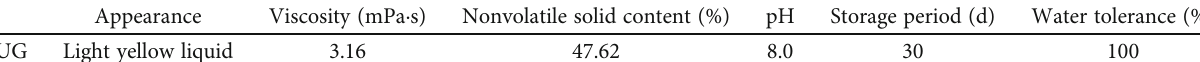
Table 1: Properties of MUG resin.